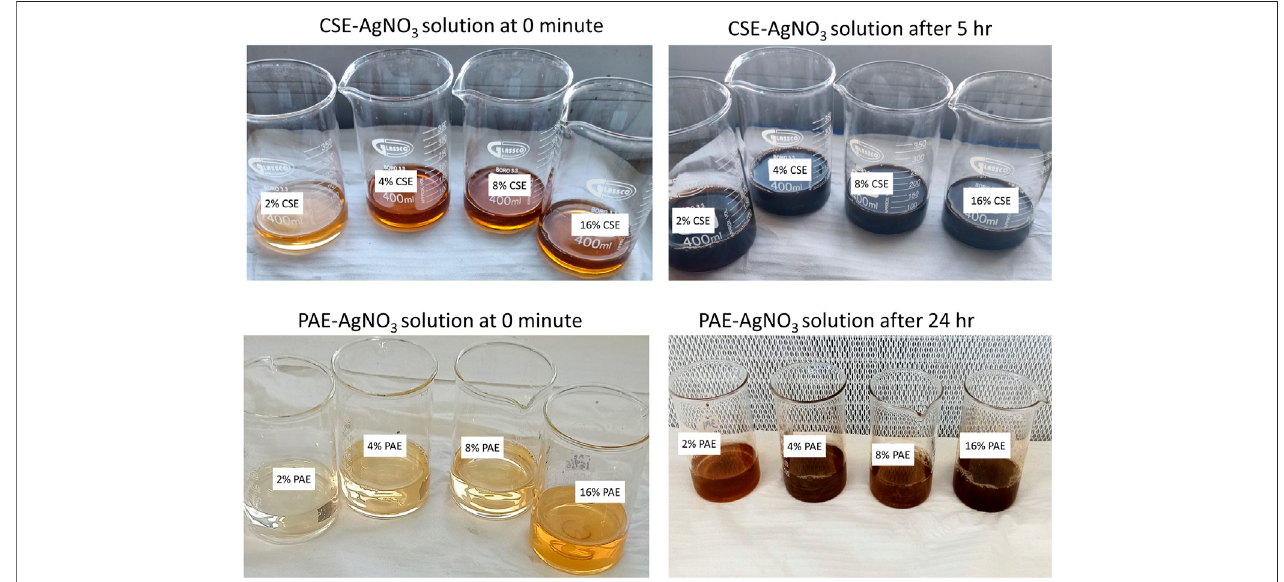
FIGURE 6 | Color transition from light brown at 0 min to dark blue for CSE-AgNO 3 and dark brown for PAE-AgNO 3 suspensions.